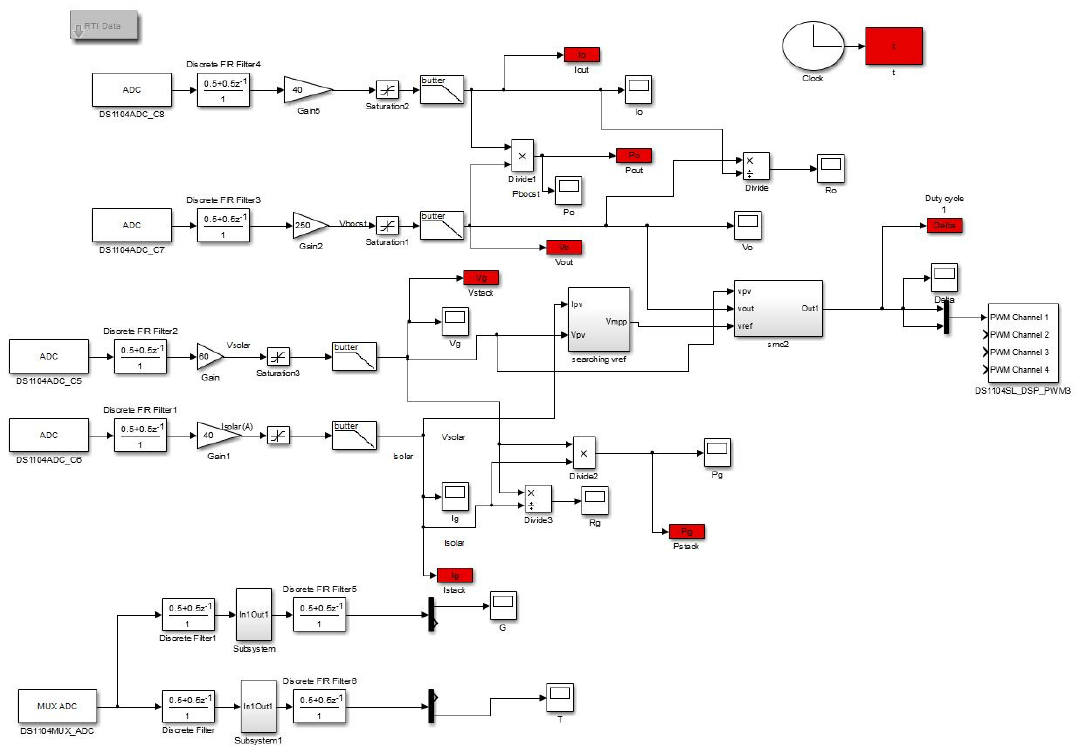
Figure 12. Simulink model of two-stage MPPT